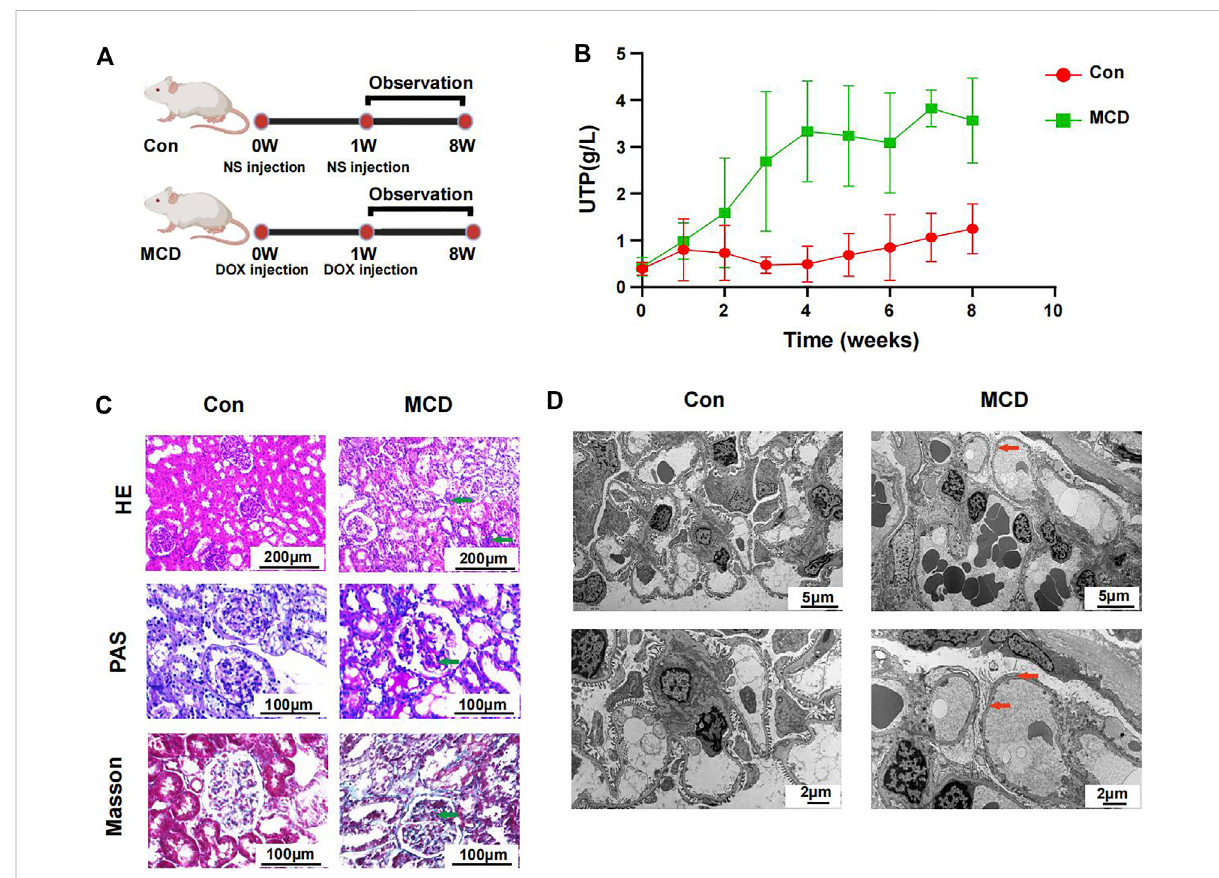
FIGURE 6 ModelingprocessandchangesofurinaryproteininCongroup( n =7)andMCDgroup( n =7). (A) DOXinjected via tail-veinatadoseof4 mg/kg bodyweightinweek0and3.5 mg/kgbodyweightinweekoneinMCDgroup.TheCongroupwasgiventhesamedoseNS. (B) Linechartshowedthe alteration of urinary protein after modeling. (C) HE, PAS and Masson staining of glomerulus in different groups. (D) Electron microscopy